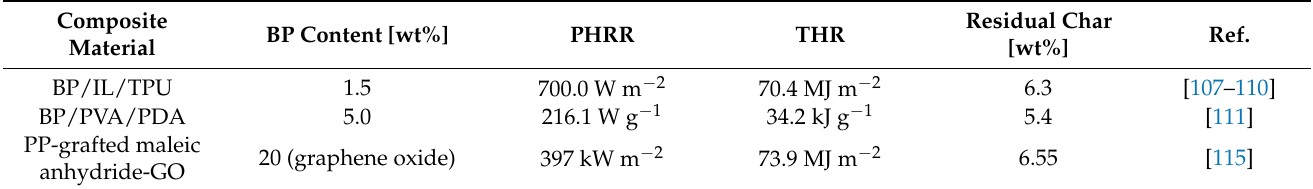
Table 3. A comparative fire retardants properties of few nanocomposites of polymers with BP and graphene.